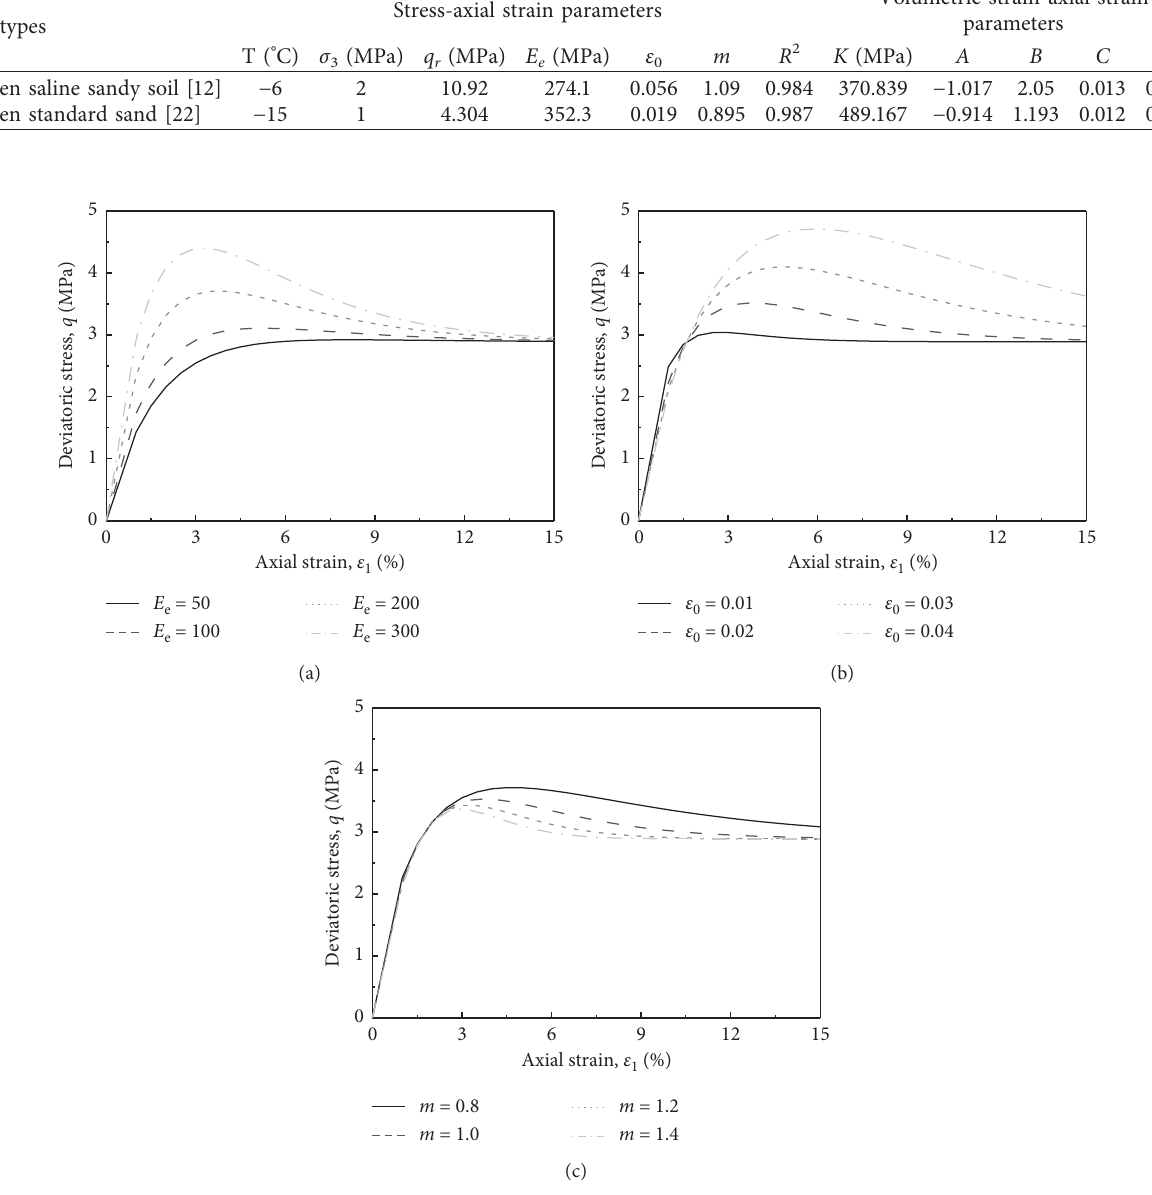
e , (b) ε 0 , and (c) m